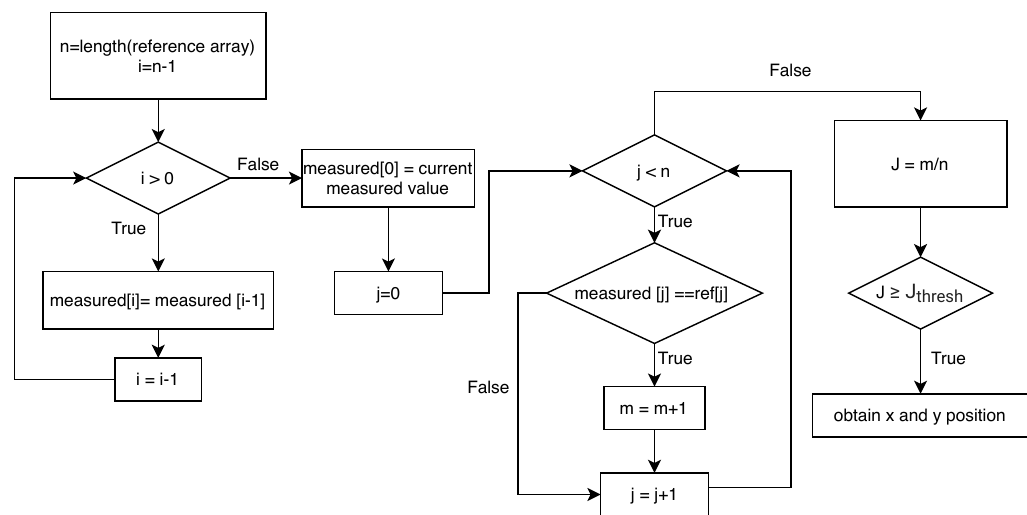
Figure 7. The diagram for the process of the proposed Signal Modulation